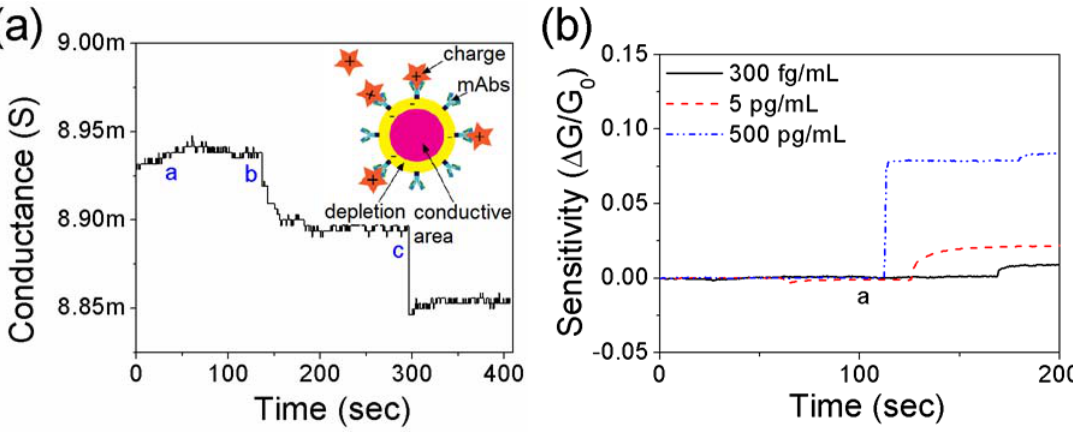
Figure 6. Tests of net surface charge effect on the functionalized PANI nanowires. ( a ) Decrease of conductance on the nanowire biosensor in sensing test with